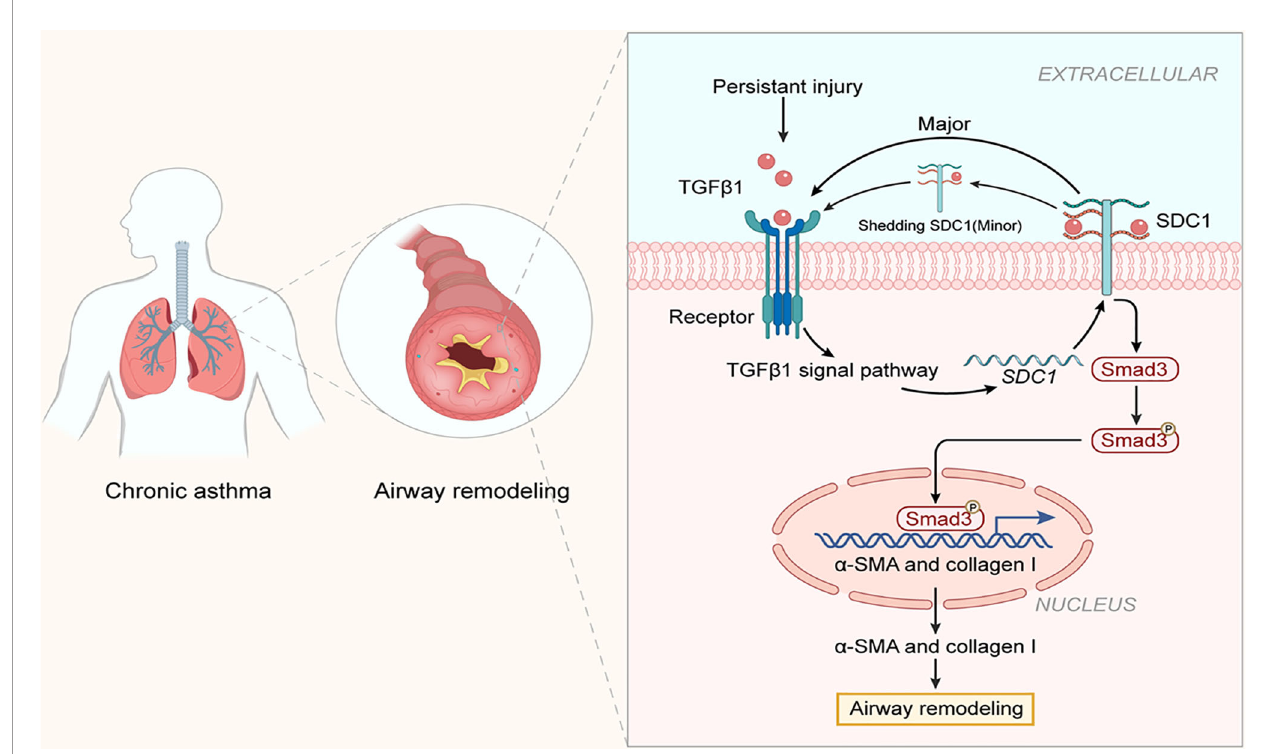
FIGURE 11 | Structure of SDC-1 overexpression with aggravated airway remodeling by strengthening TGF b 1/Smad3 signaling in OVA-induced chronic